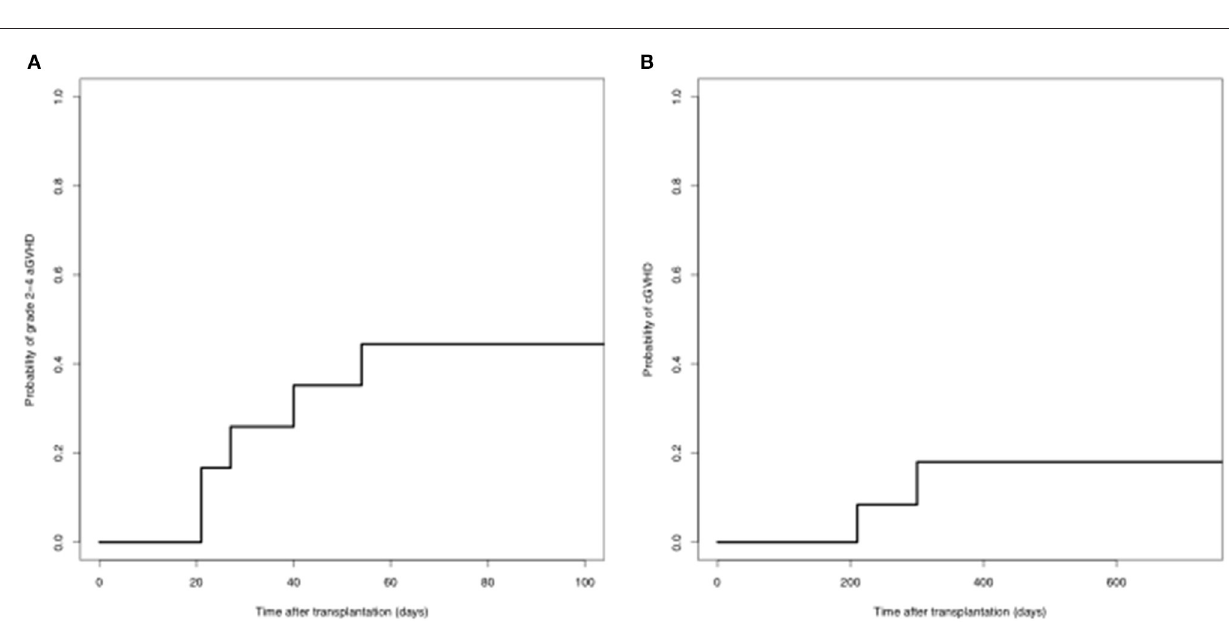
FIGURE 2 | GVHD after second transplantation (A) grade 2-4 aGVHD; (B) chronic